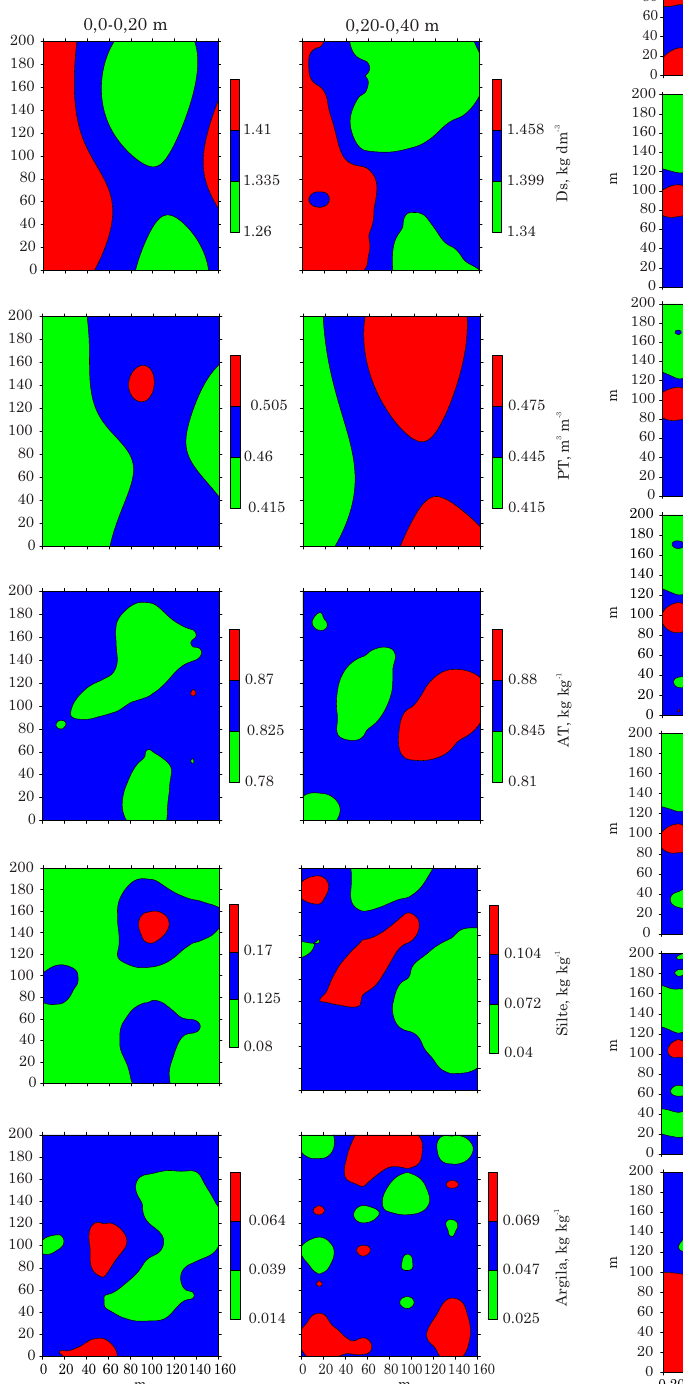
Figura 5. Distribuição espacial da umidade do solo nas diferentes tensões da curva de retenção de água e da água disponível (AD), nas camadas de 0,0-0,20 e 0,20-0,40